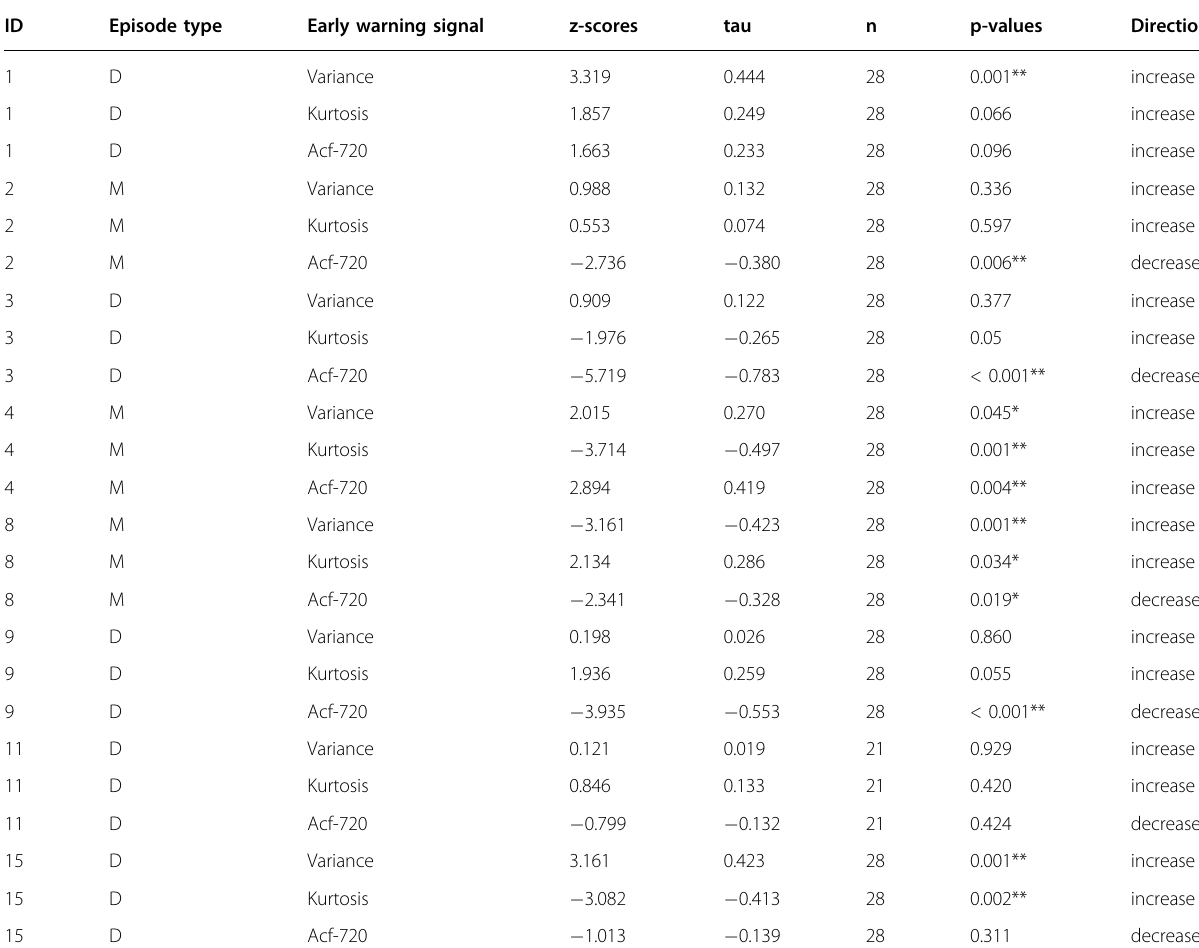
Table 1 Outcomes of the mann-kendall trend tests for ews assessment.